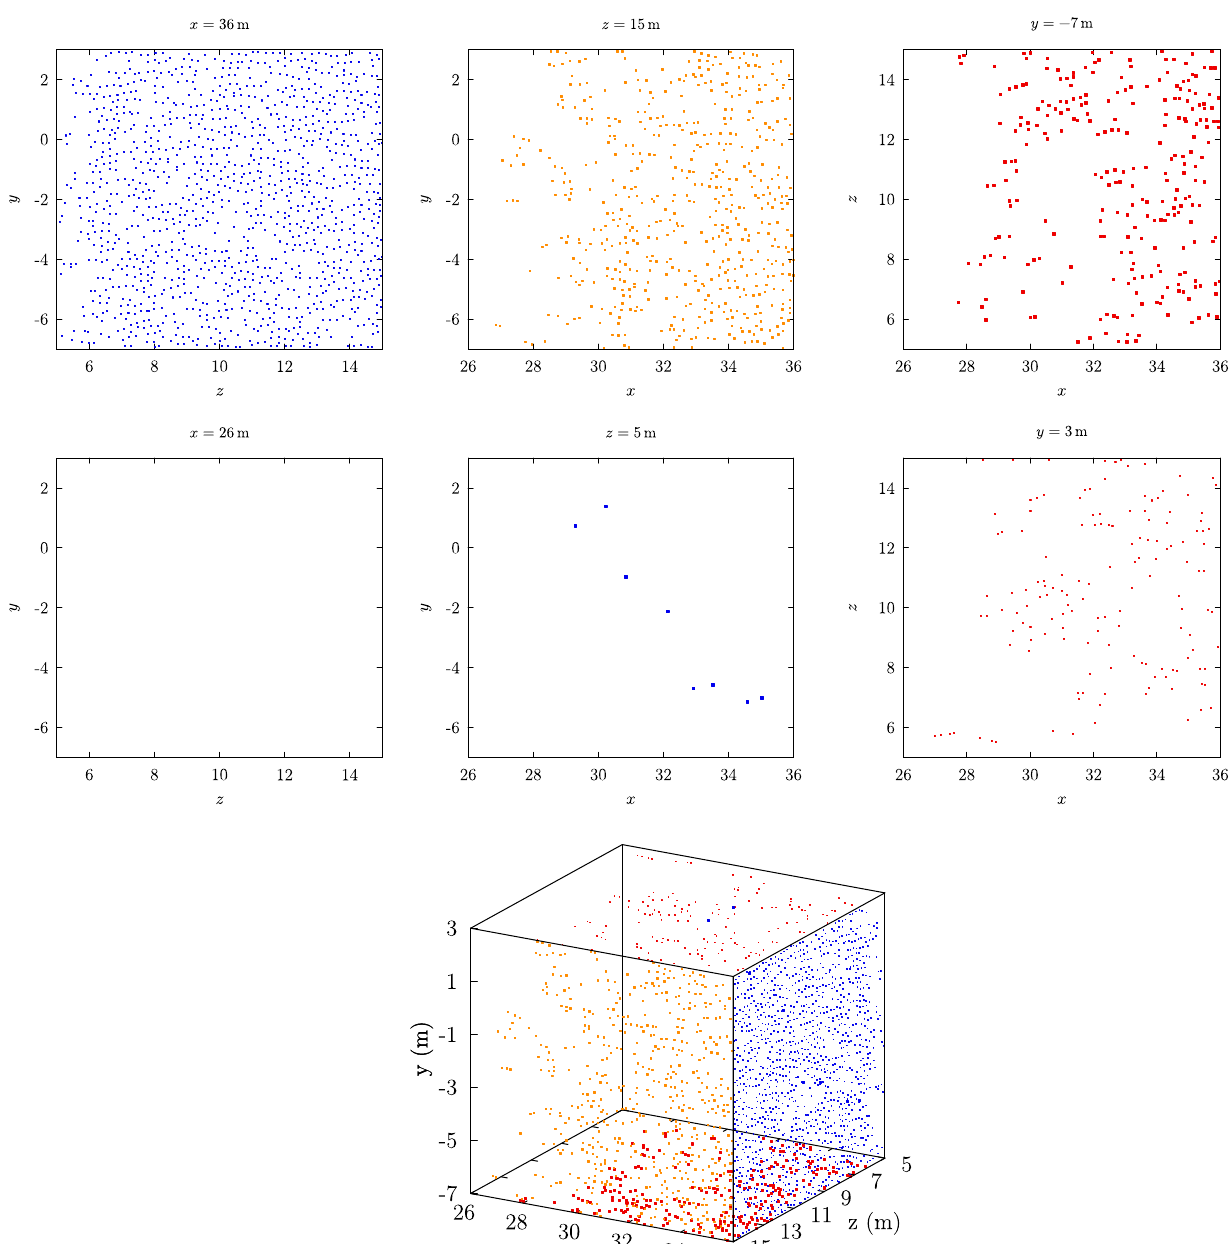
Fig. 30 Above: Scatter plot of hits on the faces of the box for 496 decays inside the box, from a h → A (cid:3) A (cid:3) → 4 τ benchmark. (From left to right) Top row: x = 36m, z = 15m, y = − 7m. Bottom row: